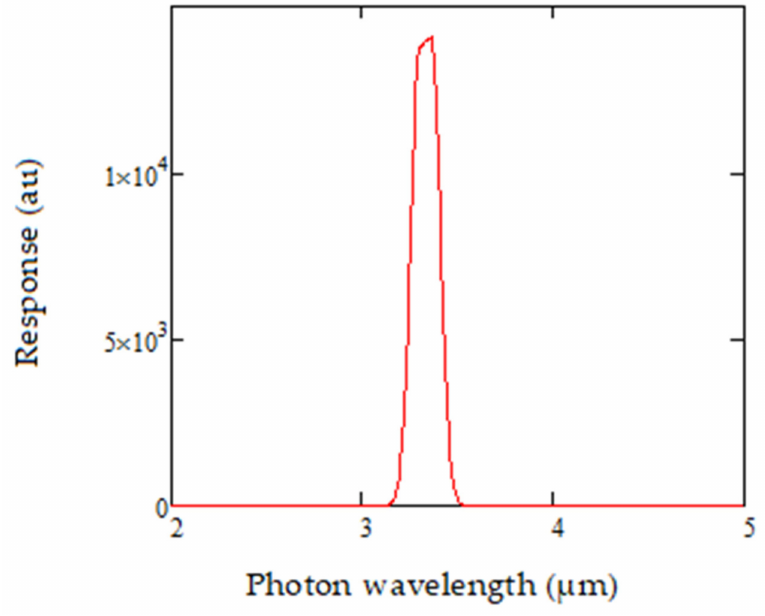
Figure 11. Source–Detector–Filter product for methane gas